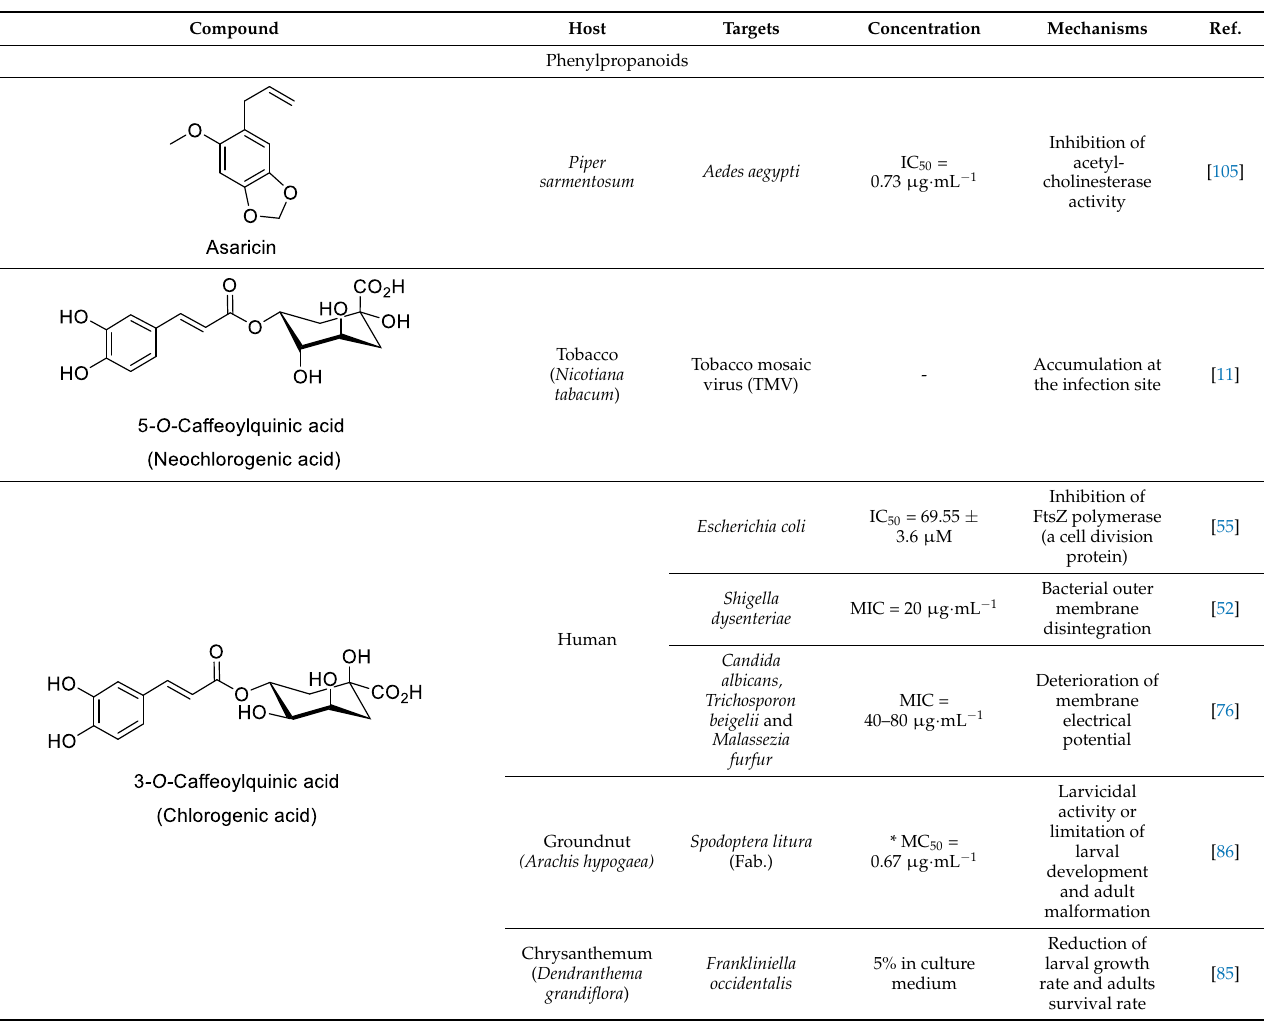
Table 1. Overview of main active PPP compounds and their putative mechanisms of action. Molecules are sorted in two families, phenylpropanoids and flavonoids, and are alphabetically presented within the families. The table does not include all the compounds cited in the text, but only those that have been documented either through genetic studies on segregating progenies, functional validation of candidate genes explaining their biosynthesis, direct toxicity tests on the targets, or histological observations of the effects of the compound on the target. Compounds for which the literature only relates a correlation between resistance level and metabolite content are not described. Concentration range is given for the compounds with biological activity reported in the corresponding references. MIC, minimum inhibitory concentration; EC 50 , half-maximal effective concentration; IC 50 , half-maximal inhibitory concentration; MC 50 , half larval mortality concentration. Compound Host Targets Concentration Mechanisms Ref.